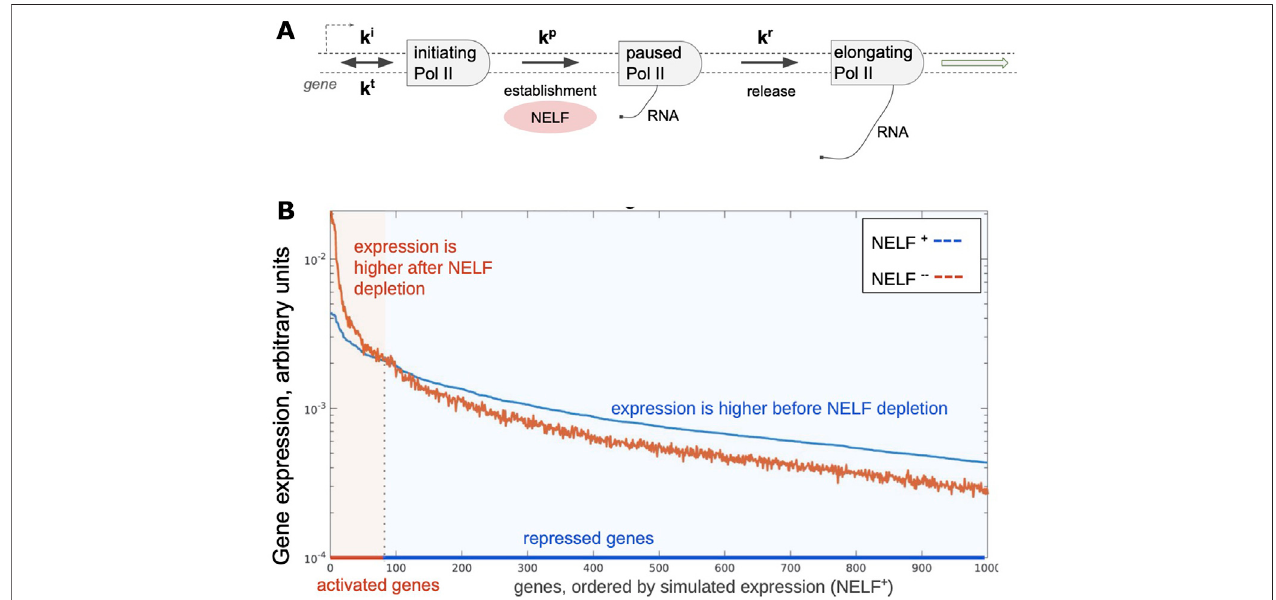
FIGURE 3 | Simulated changes in gene expression upon depletion of a pausing factor. (A) A scheme of steps in Pol II pausing. Initiation (ki), pausing (kp), and release (kr) constants were randomly distributed for 1000 simulated genes (with cauchy and two gaussian probability distribution functions, respectively); termination constant (kt) was the same for all simulated genes. (B) Results of simulation showing steady-state distribution of gene expression (light colored arrow) levels with two different amounts of total available NELF in the system, which results in activation and repression of